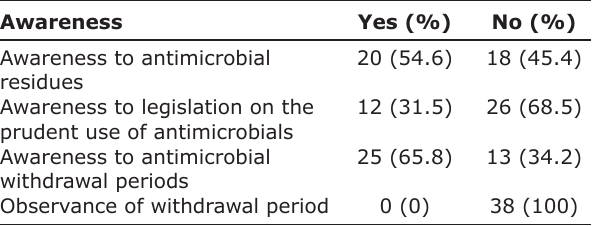
Table-2: Awareness to prudent use of antimicrobial in poultry and livestock production and observance of withdrawal